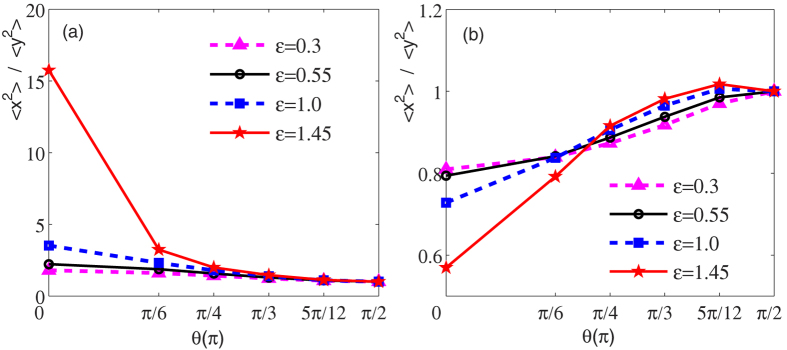
The profiles of the dimensionless parameter 〈x2〉/〈y2〉 for the density distributions illustrated inFig. 1.(a) Dipolar component 1; (b) Non-dipolar component 2.